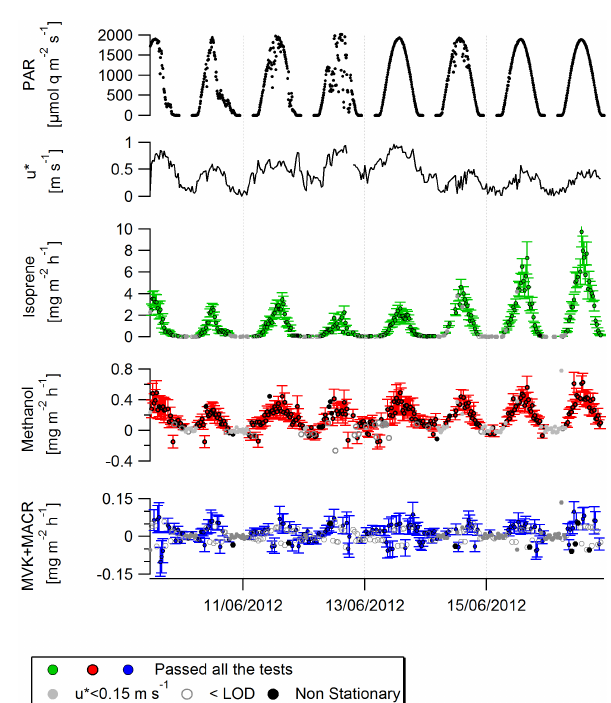
Figure 5. Time series of MVK + MACR, methanol and isoprene fluxes along with friction velocity and PAR measured above the canopy from 4 June to 16 June. Flux error bars show ± stan- dard deviation of the covariance for t lag far away from the true lag ( + 150, −